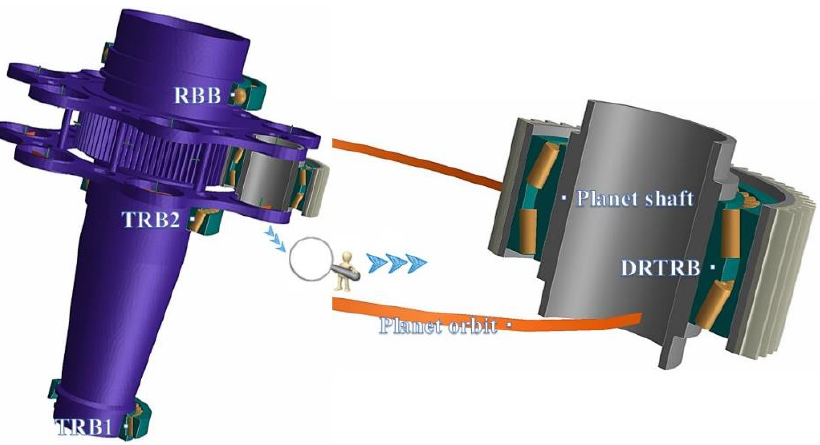
Figure 5. Bearing structure in planetary system. Table 2. Bearing parameters in planetary system.